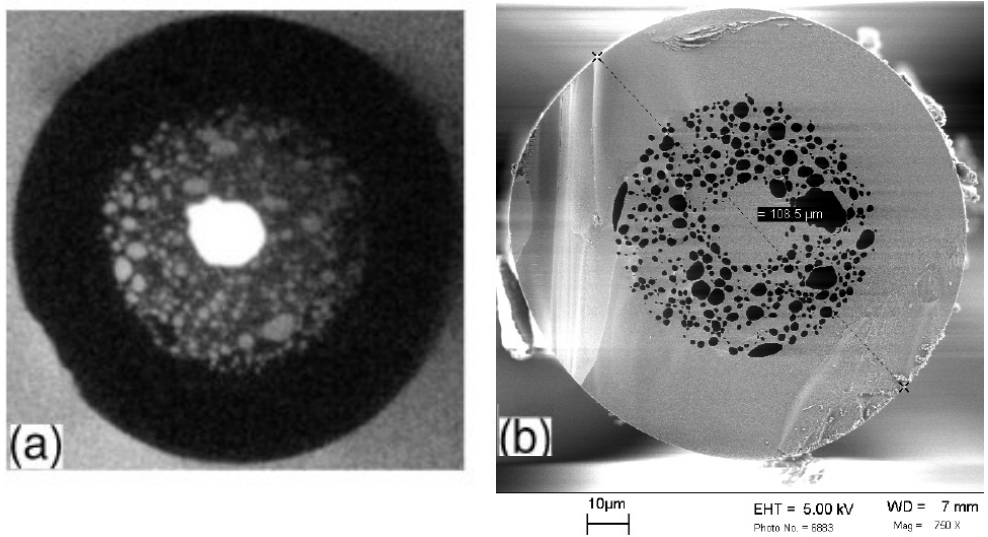
Figure 2. (a) Optical image of RHOF, (b) SEM image of